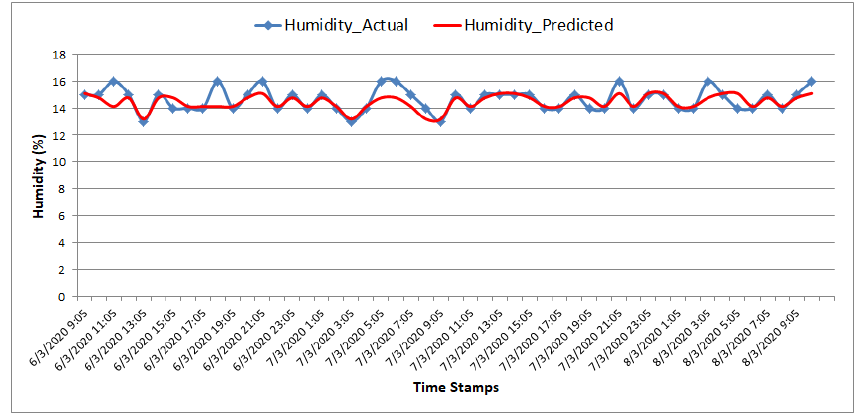
Figure 25. Hourly Predicted values of Humidity vs. Actual